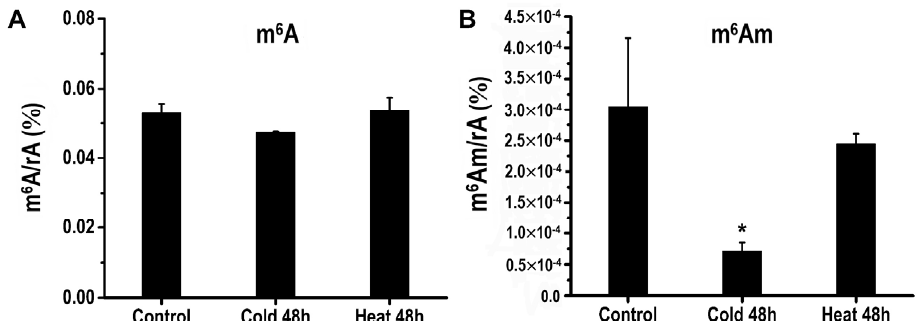
Figure 7. The amount of m 6 A and m 6 Am in tomato leaves by LC-MS/MS analysis. The changes in ( A ) m 6 A and ( B ) m 6 Am contents under cold and heat treatment. The 30-day-old tomato seedlings were treated under cold and heat conditions for 48 h. * Refer to significant differences with p < 0.05 compared to the control.